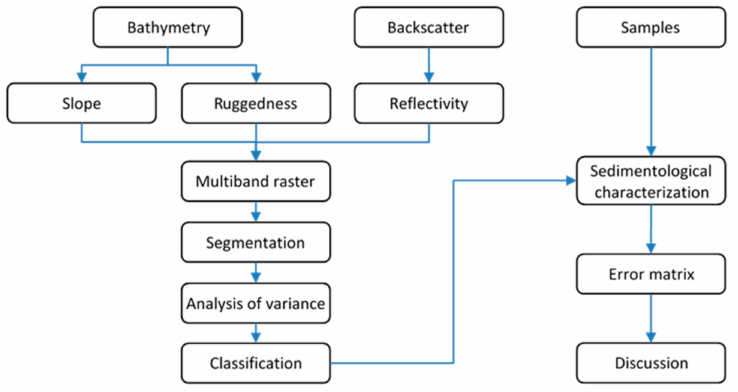
Figure 2. Workflow of the applied